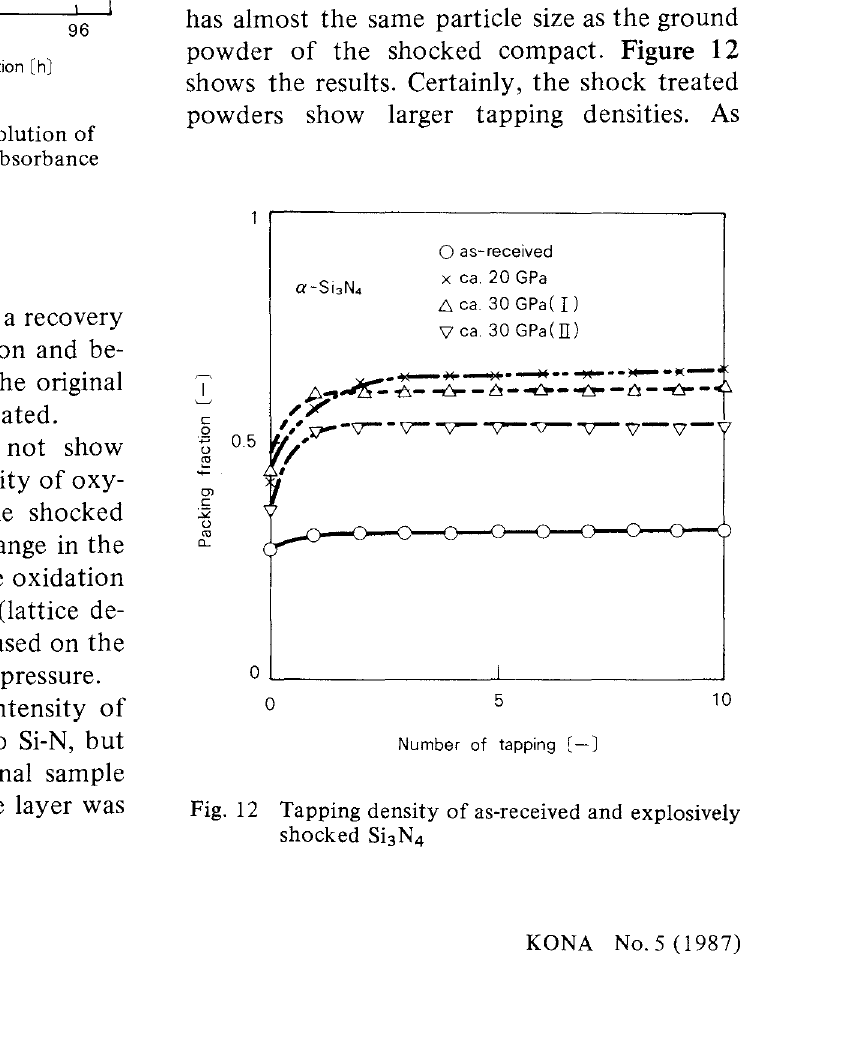
Fig. 12 Tapping density of as-received and explosively shocked